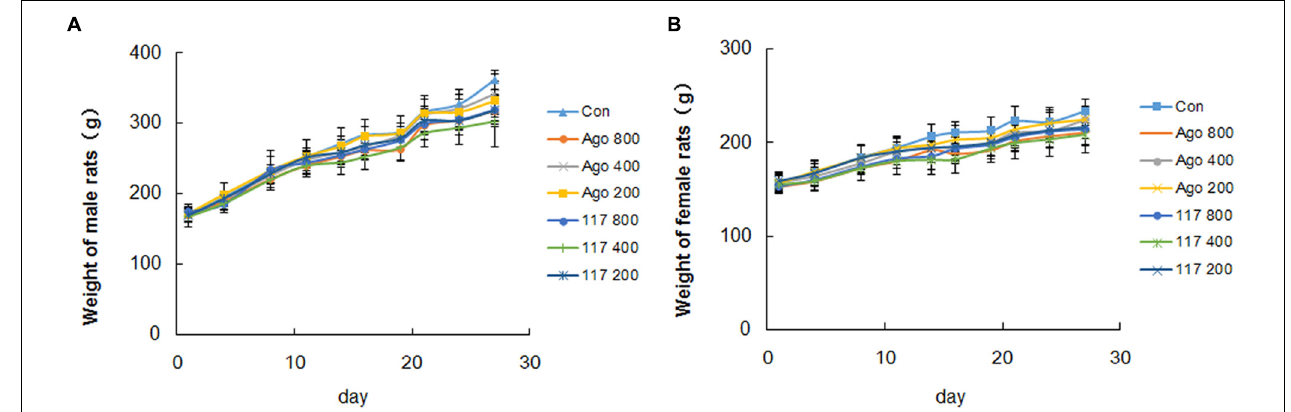
FIGURE 3 | Effect of AGO and GW117 on the body weight of male (A) and female (B) rats ( n = 6).